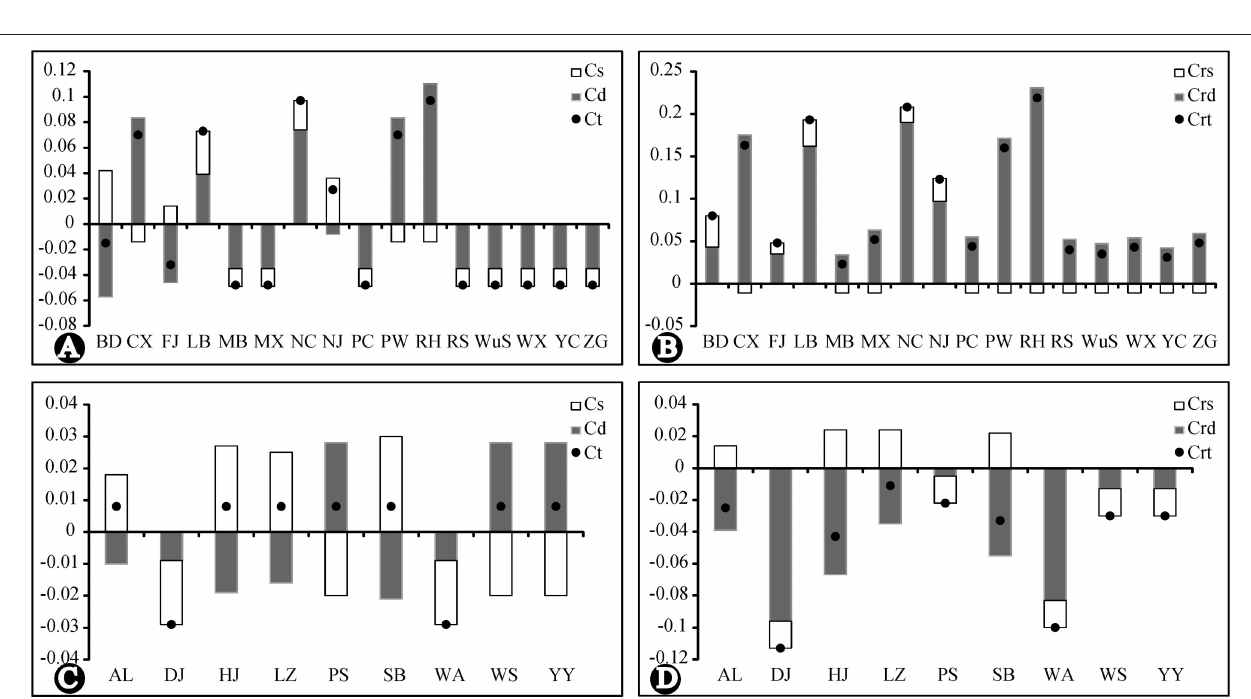
FIGURE 6 | Contribution of each population to the genetic and allelic diversity of R. chinensis var. spontanea and R. lucidissima complex. Cs , the contribution of genetic diversity. Cd , the contribution of genetic differentiation. CT , the contribution of total diversity. Crs, the contribution of allelic diversity. Crd , the contribution of allelic differentiation. CrR , the contribution of total allelic richness. (A,B) : R. chinensis var.spontanea . (C,D) : R.lucidisssima .